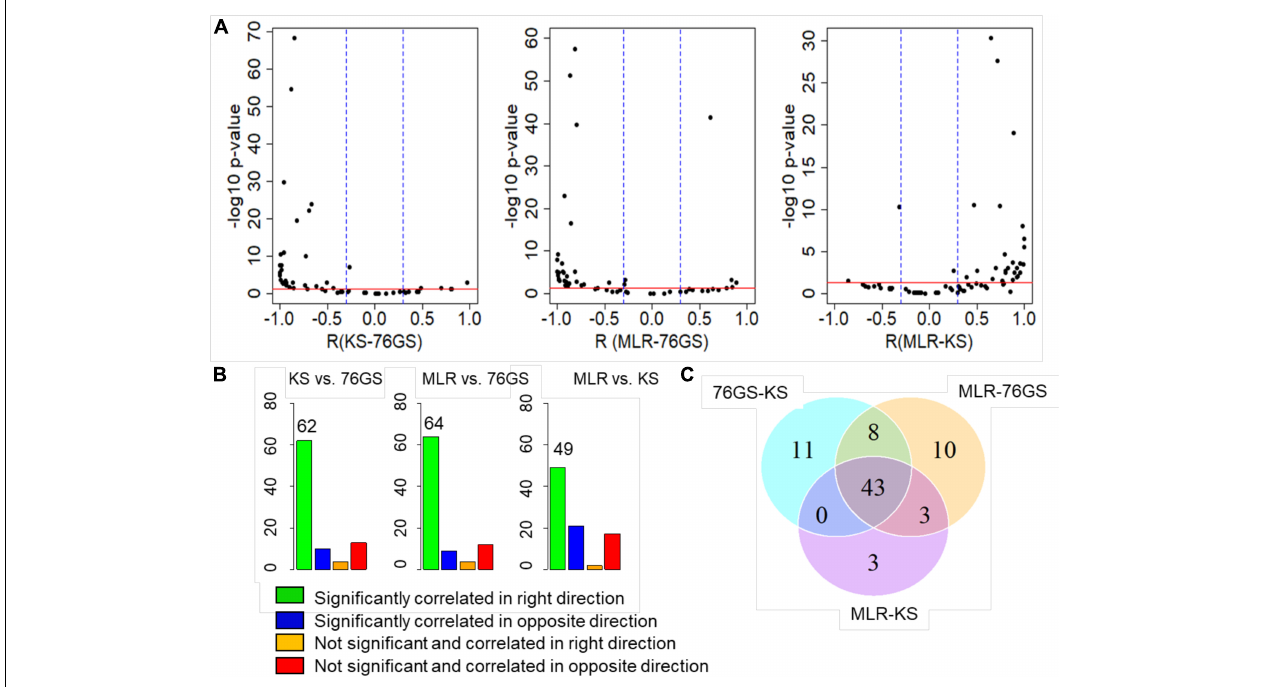
FIGURE 4 | Plots depicting pairwise comparisons of all three EMT scores. (A) Volcano plots showing the correlation of different EMT scoring methods across 85 different GEO microarray datasets along with the p -values for the respective correlation coefficient values. In each case, –log10( p -value) is plotted as a function of Pearson’s correlation coefficient. Thresholds for correlation ( R < –0.3 or R > 0.3; vertical blue lines) and p -values ( p < 0.05; horizontal red line) are denoted. (B) Bar plots for different categories based on the correlation sign and statistical significance of all three pairwise comparisons across 85 datasets. p < 0.05 and R < − 0.3 or R > 0.3. (C) Venn diagram showing the common GEO datasets across all pairwise comparisons that are significantly correlated in the expected